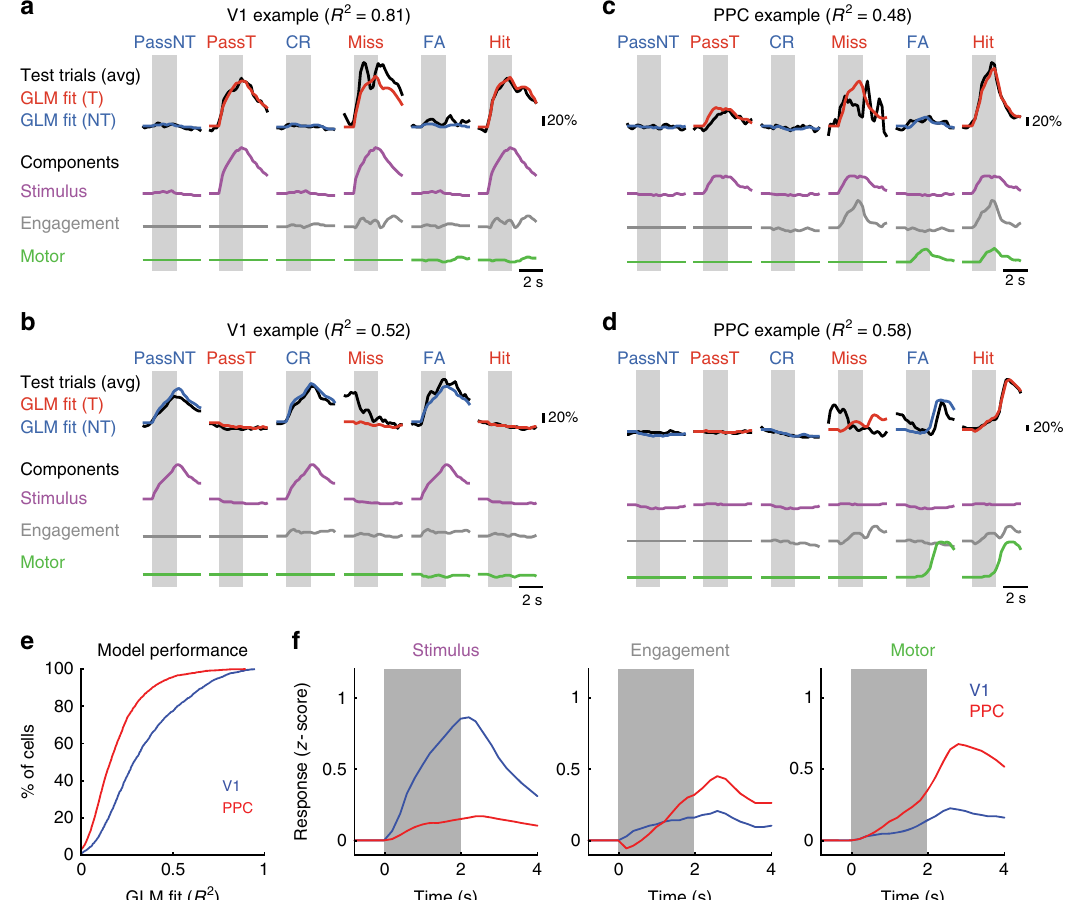
Fig 4 Generalized linear model (GLM) of V1 and PPC responses. A generalized linear model was fi t to training data to predict the calcium responses of individual V1 and PPC neurons using lagged predictors for stimulus, engagement and motor action (licking). a GLM model performance for an example V1 neuron. GLM fi ts on Target (red) and Non-target (blue) trials were compared with trial-averaged test data (black) across Passive (PassNT, PassT), Engaged No-Lick (Miss, FA), and Engaged Lick (FA, Hit) conditions. GLM components related to Stimulus (purple), Engagement (gray), and Motor (green) were summed to generate overall GLM fi t. Shaded region represents time of stimulus presentation. b Same as a , but for a different, nontarget-preferring V1 neuron. c , d GLM model performance for two example PPC neurons. One neuron has a strong Engagement component ( c ), while the other has a stronger Motor component ( d ). e Cumulative histogram of model prediction performance on test trials, quanti fi ed for each cell as fraction of variance explained ( R 2 ), for both V1 (blue, n = 1915 cells) and PPC (red, n = 3524). f Population-averaged GLM model components related to Stimulus (left), Engagement (middle), and Motor (right), for both V1 (blue) and PPC (red). For Stimulus and Engagement components, the preferred stimulus component for each cell was used for averaging. Calcium responses were z -scored before model fi tting. Light shaded gray region demarcates duration of